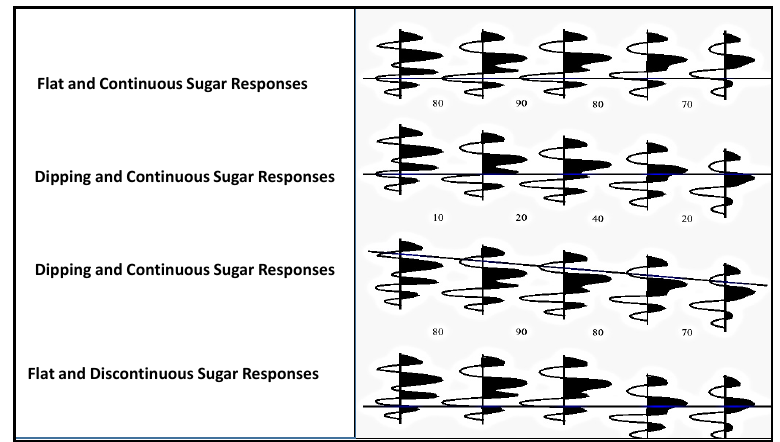
Figure 11. Analysis of sugar levels attributed by traces.